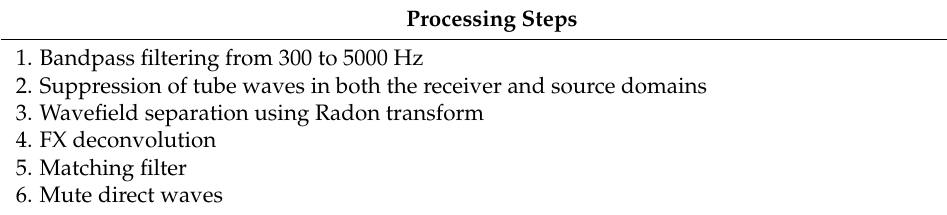
Table 1. Processing steps used in the real time-lapse cross-well datasets.